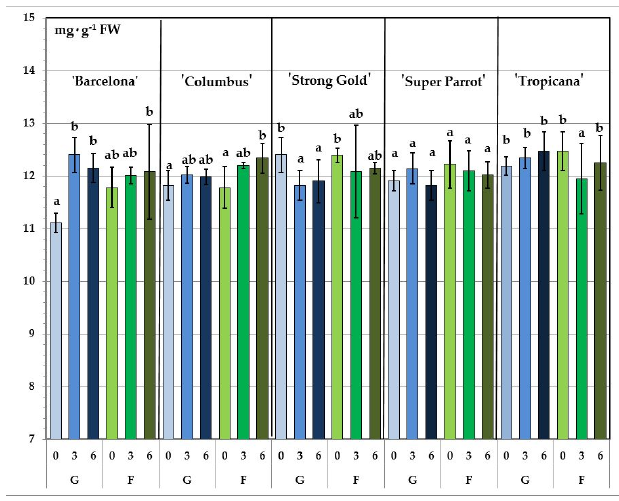
Figure 1. Total phenolic content of tulip flowers depends on cultivar. 0, 3, 6—time of storage (days). G, F—type of cultivation (greenhouse, field).